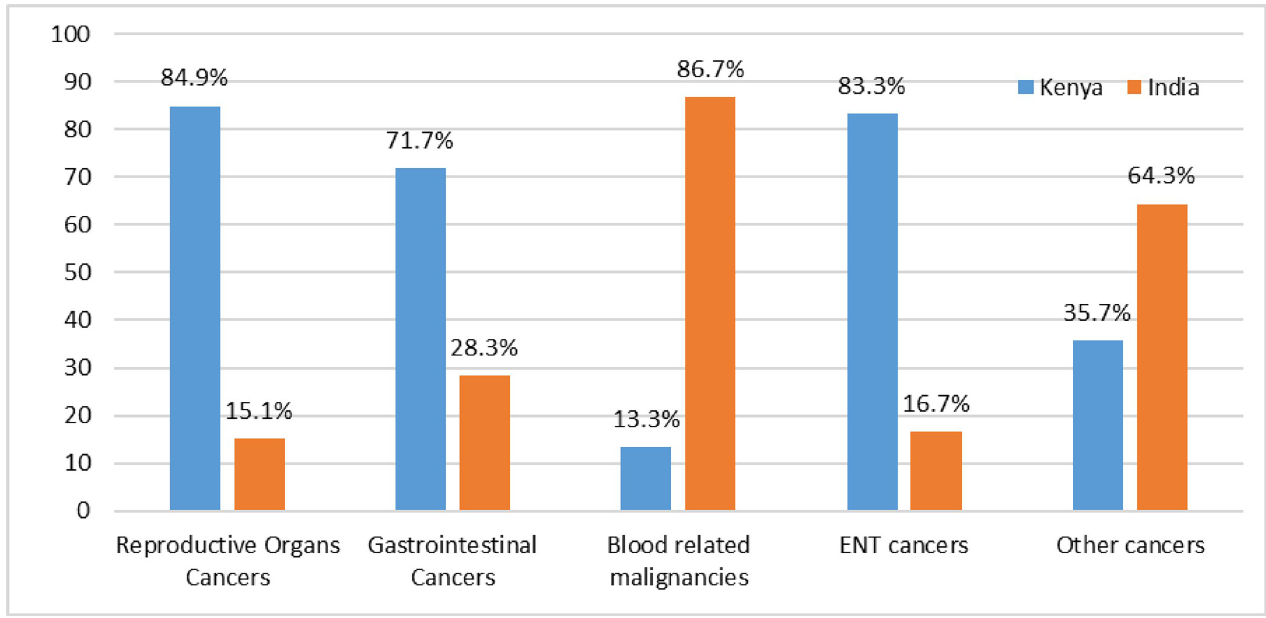
Fig 2. Proportion of study participants disaggregated by the type of cancers and the country in which they received treatment.